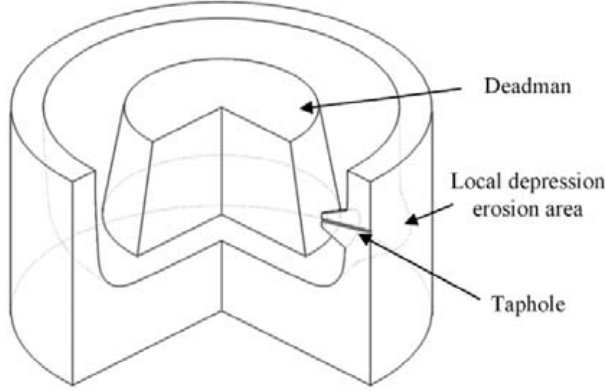
Figure 3. 3D model of the elephant ‐ type erosion hearth.